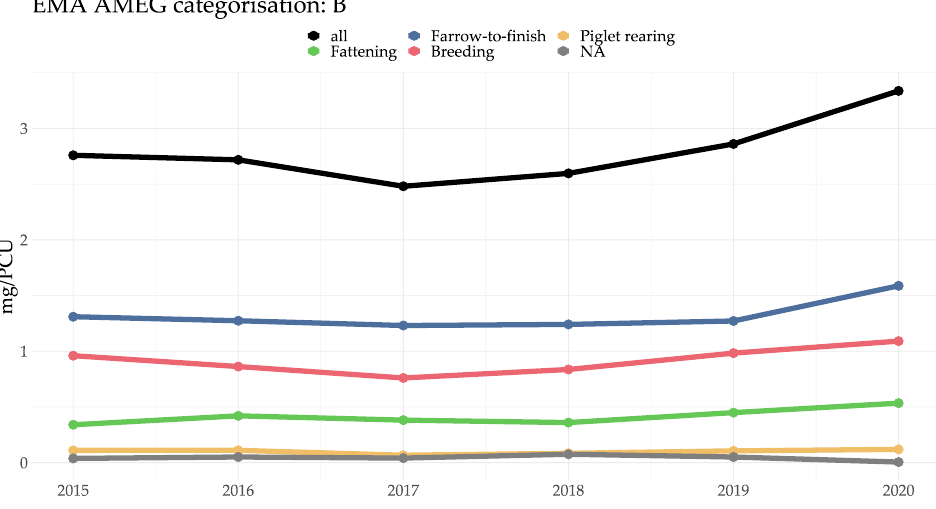
Figure 4. Antimicrobials (in mg/PCU) dispensed in Category B (the use of which should be “re- stricted”) by pig production system over